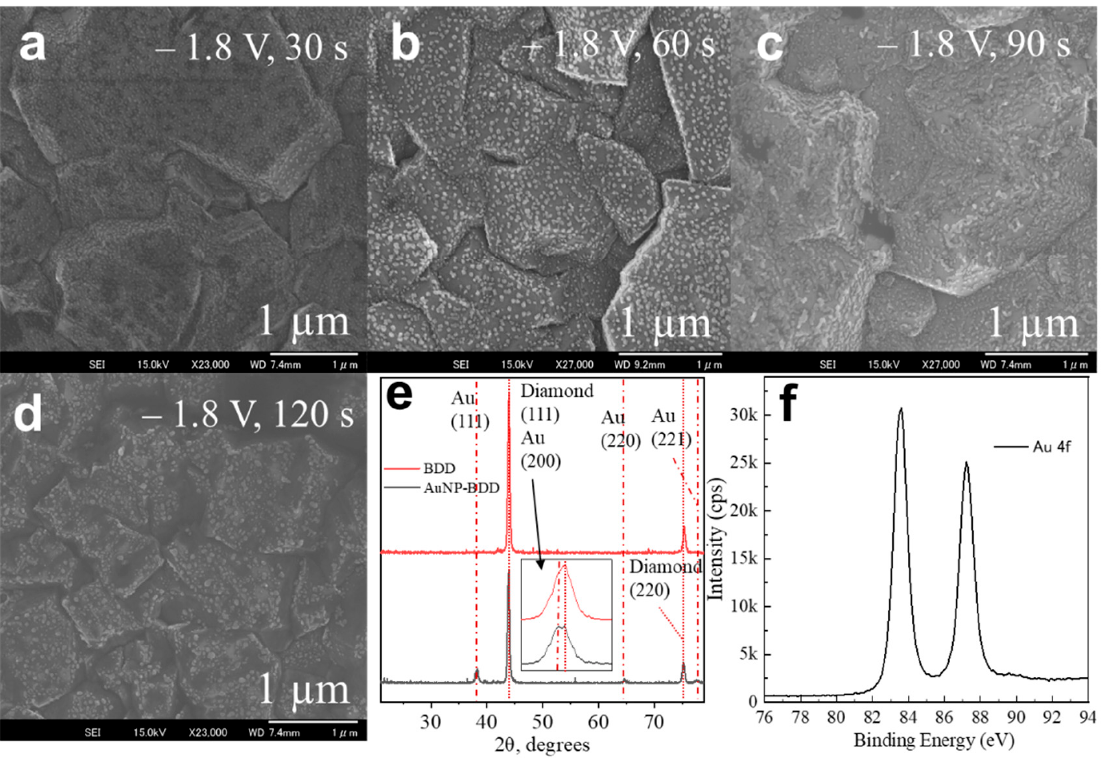
Figure 2. Effect of the AuNPs synthesis time on the particle density of the BDD. ( a – d ) SEM images of AuNPs formed on BDD films over different deposition times ranging from 30 to 120 s. ( e ) XRD patterns of AuNP-modified BDD (AuNP-BDD) and BDD samples. ( f ) X-ray photoelectron spectrum confirming gold deposition on BDD after 30 s of Au deposition.